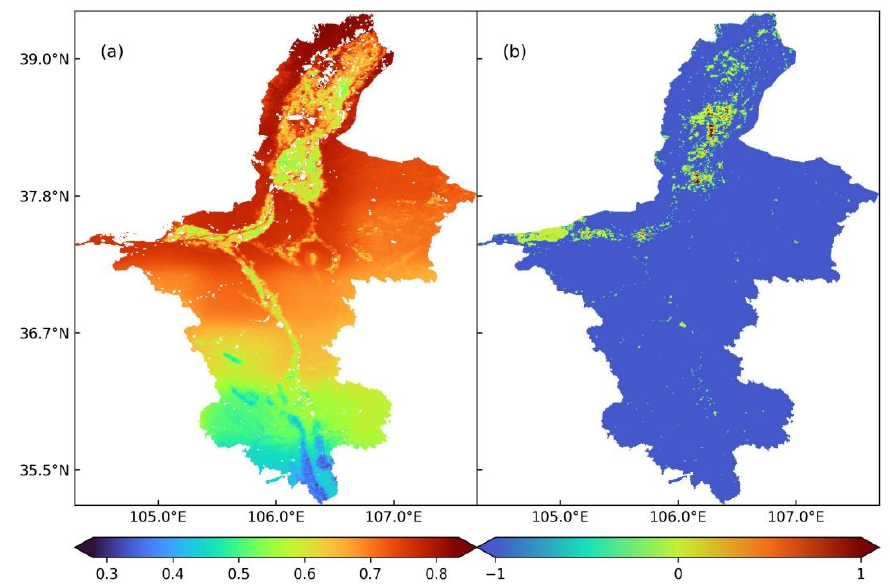
Figure 6. Evaluation of the spatial distribution patterns of average annual EDI. ( a ) Spatial distribution of average annual EDI; ( b ) Spatial distribution of EDI variation trend.